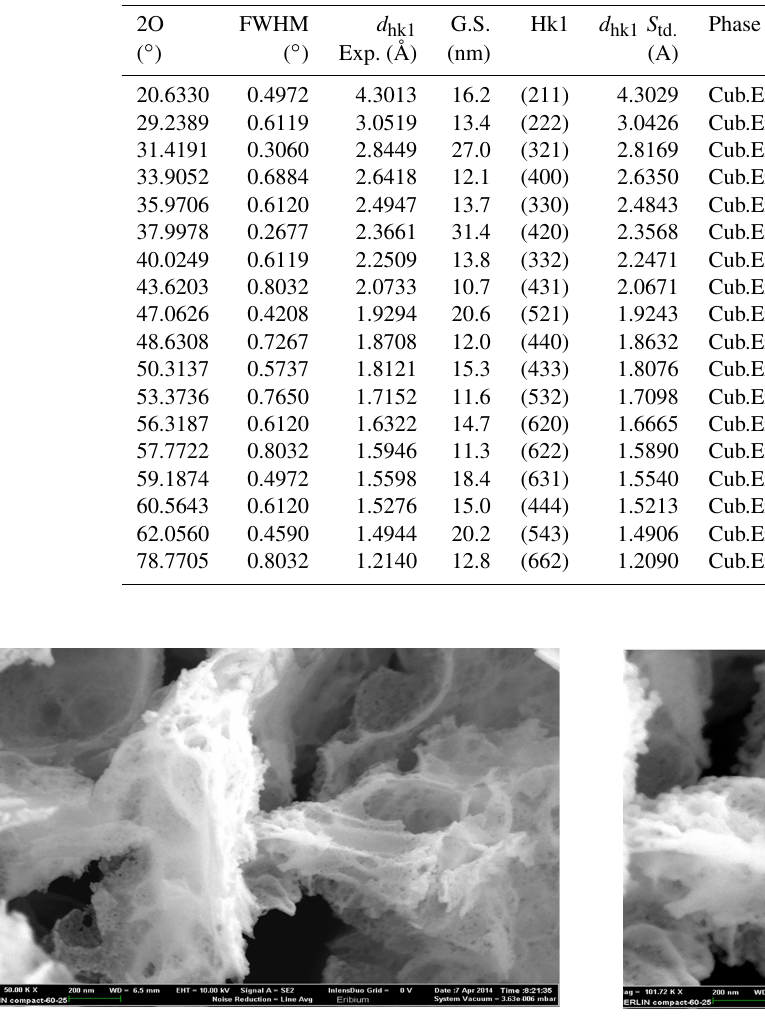
Figure 10. SEM image of nano-sized Er 2 O 3 at 101720 times mag-